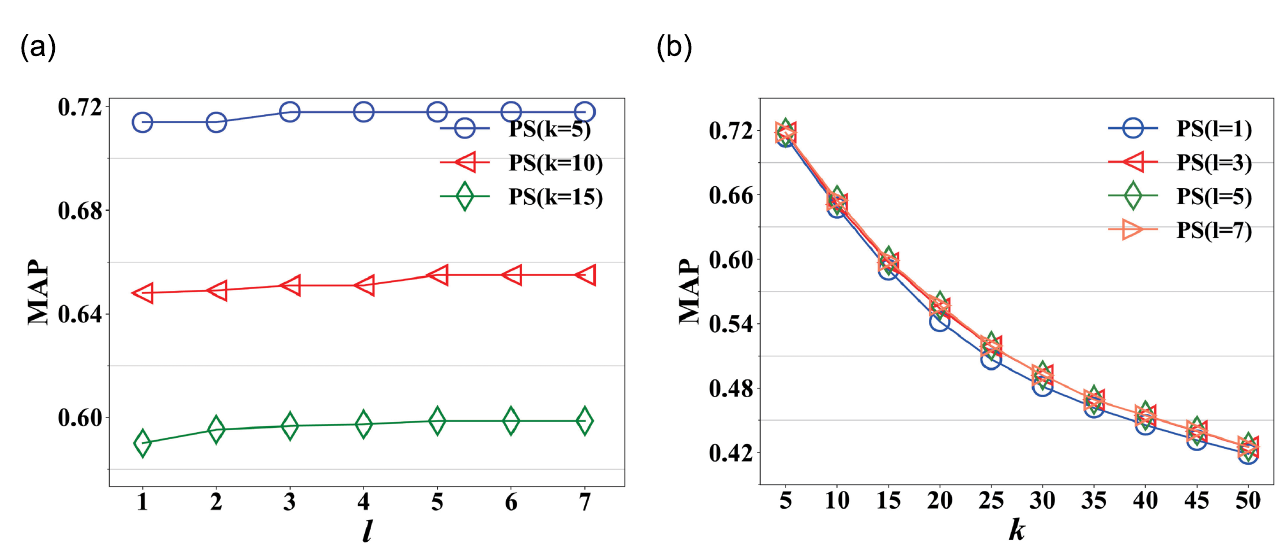
Fig 2. MAP on varying l and k respectively in Nipic. (a) MAP on varying l , (b) MAP on varying k .